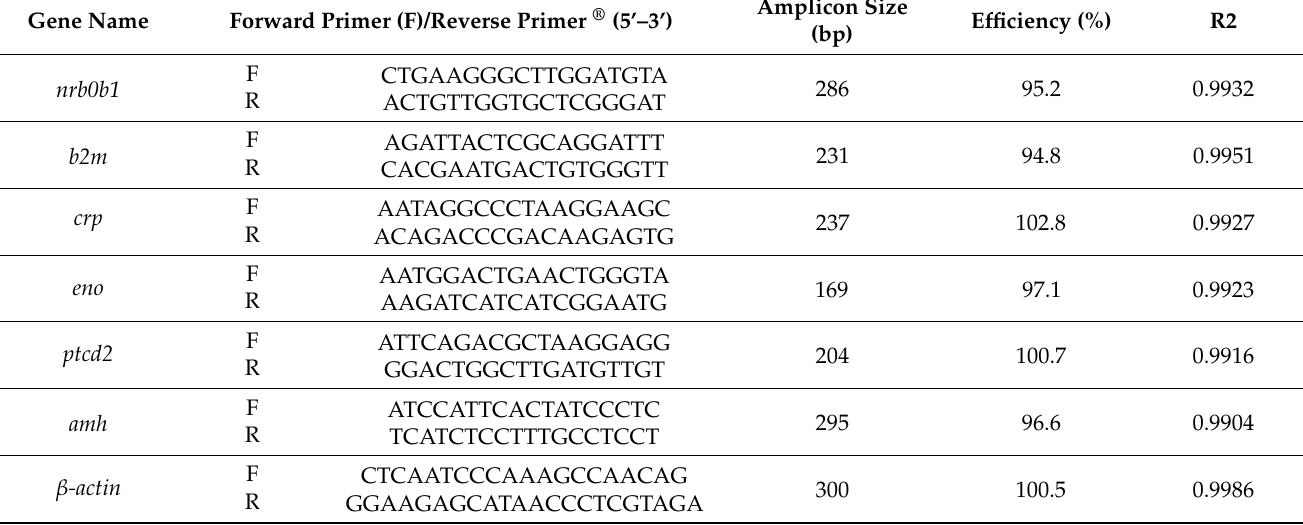
Table 1. List of qPCR